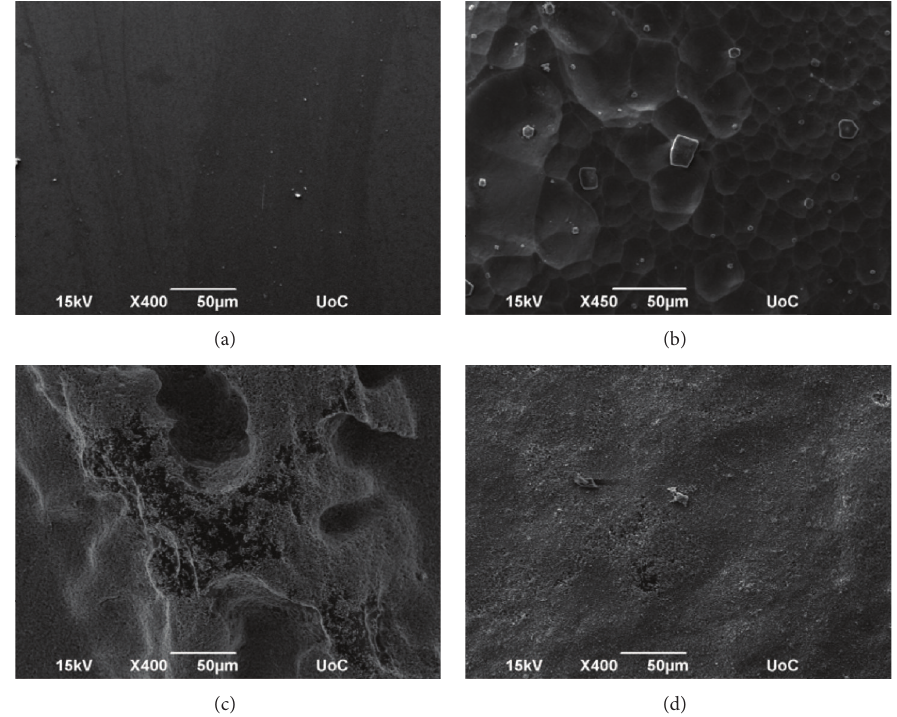
Figure 5: SEM images of (a) glass plates; (b) glass plates treated with HF solution; (c) 3.7 mg fresh ZnO (1.6mg/cm 2 ) immobilized onto the plate; and (d) 3.7 mg used ZnO (1.6mg/cm 2 ) immobilized onto the plate.